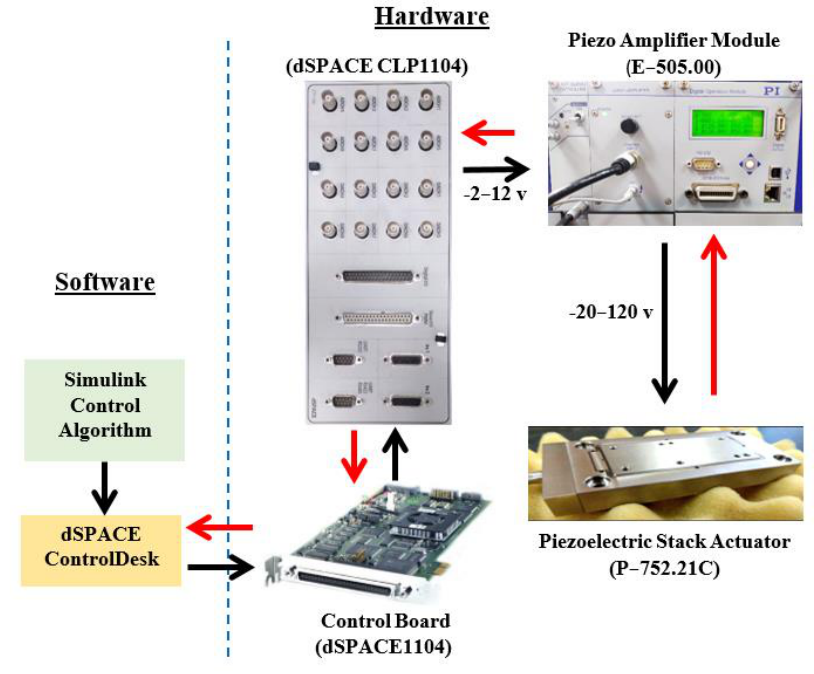
Figure 1. Hardware and software workflow.